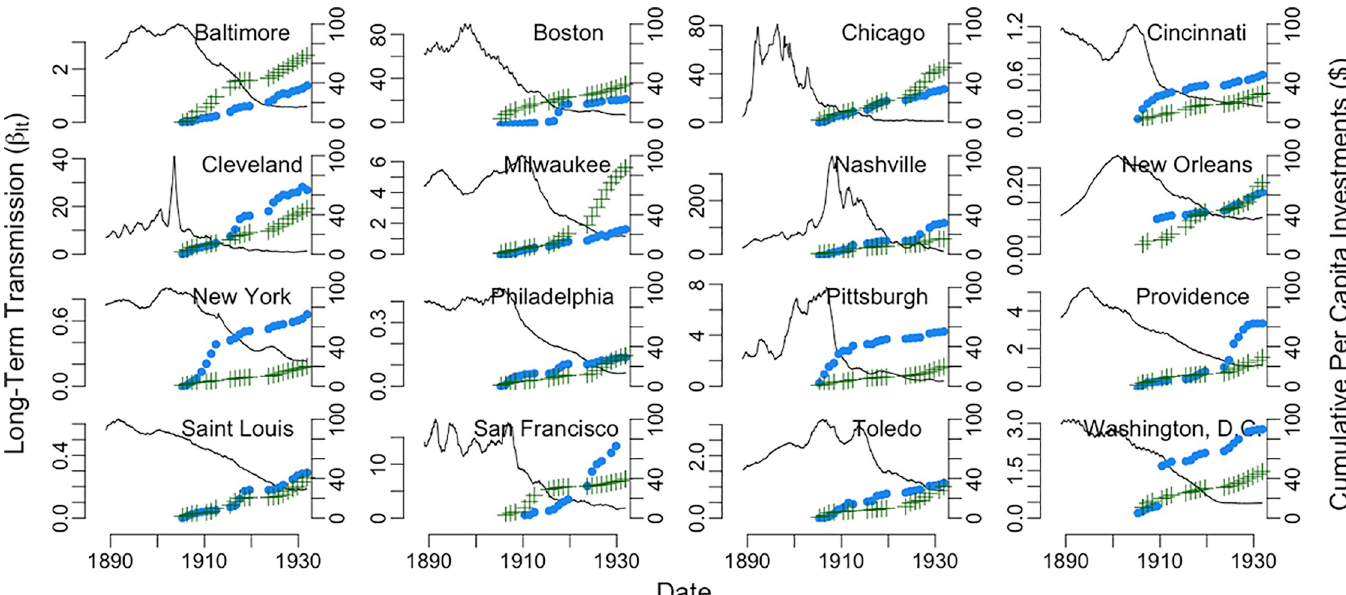
Fig 2. Long-term typhoid transmission rate by city estimated from Time-series Susceptible-Infectious-Recovered models. The estimated long-term transmission rate ( β lt , solid black line) is plotted for each city, by four-week generation interval. Overall per capita investments in the water supply (blue circles) and sewer system (green pluses) in 1931 US dollars are also shown for each city from